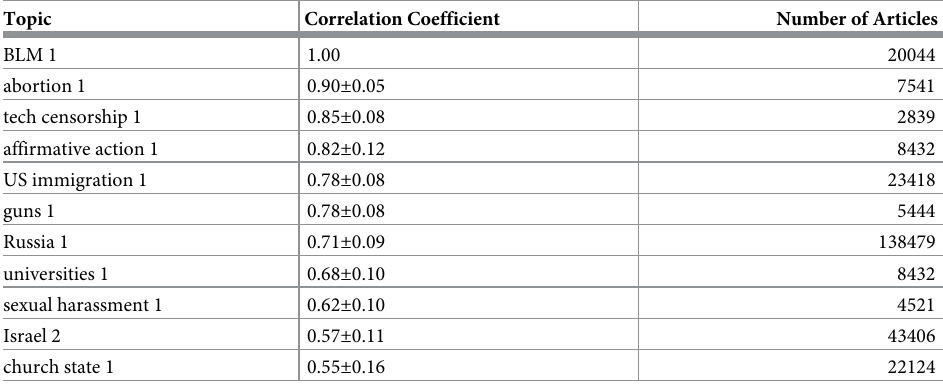
Table 3. BLM correlation coefficients: Topics most correlated with the BLM topic. Topic Correlation